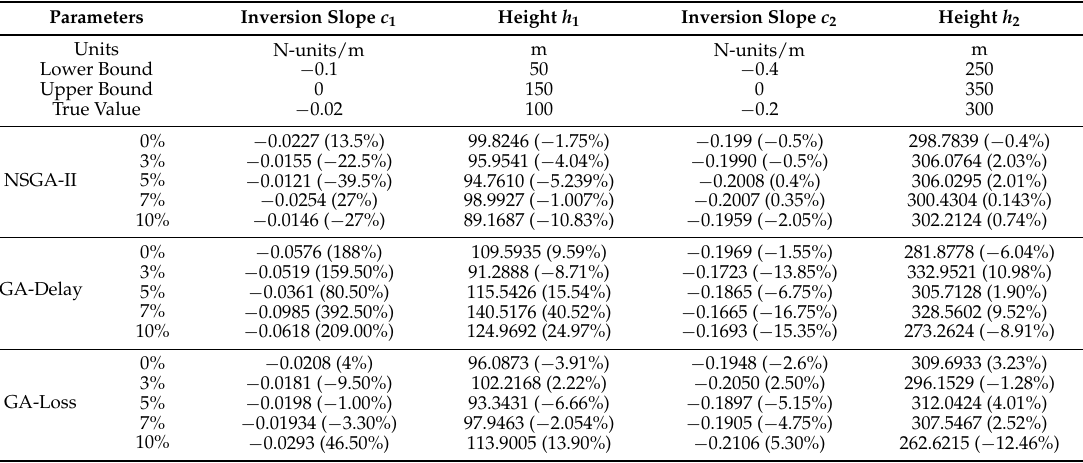
Table 1. The value of inversion parameters under noiseless and adding noise